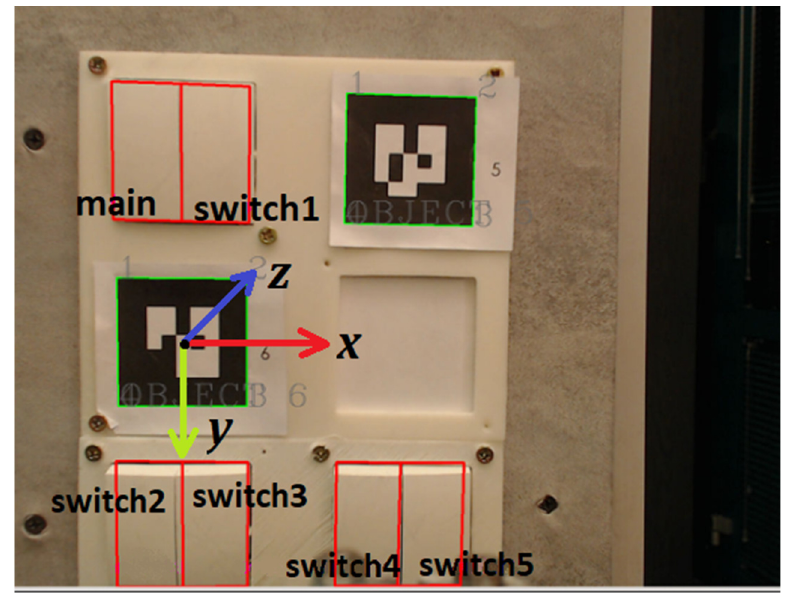
Figure 3. View from the camera mounted on the gripper with recognized markers and marked switches.